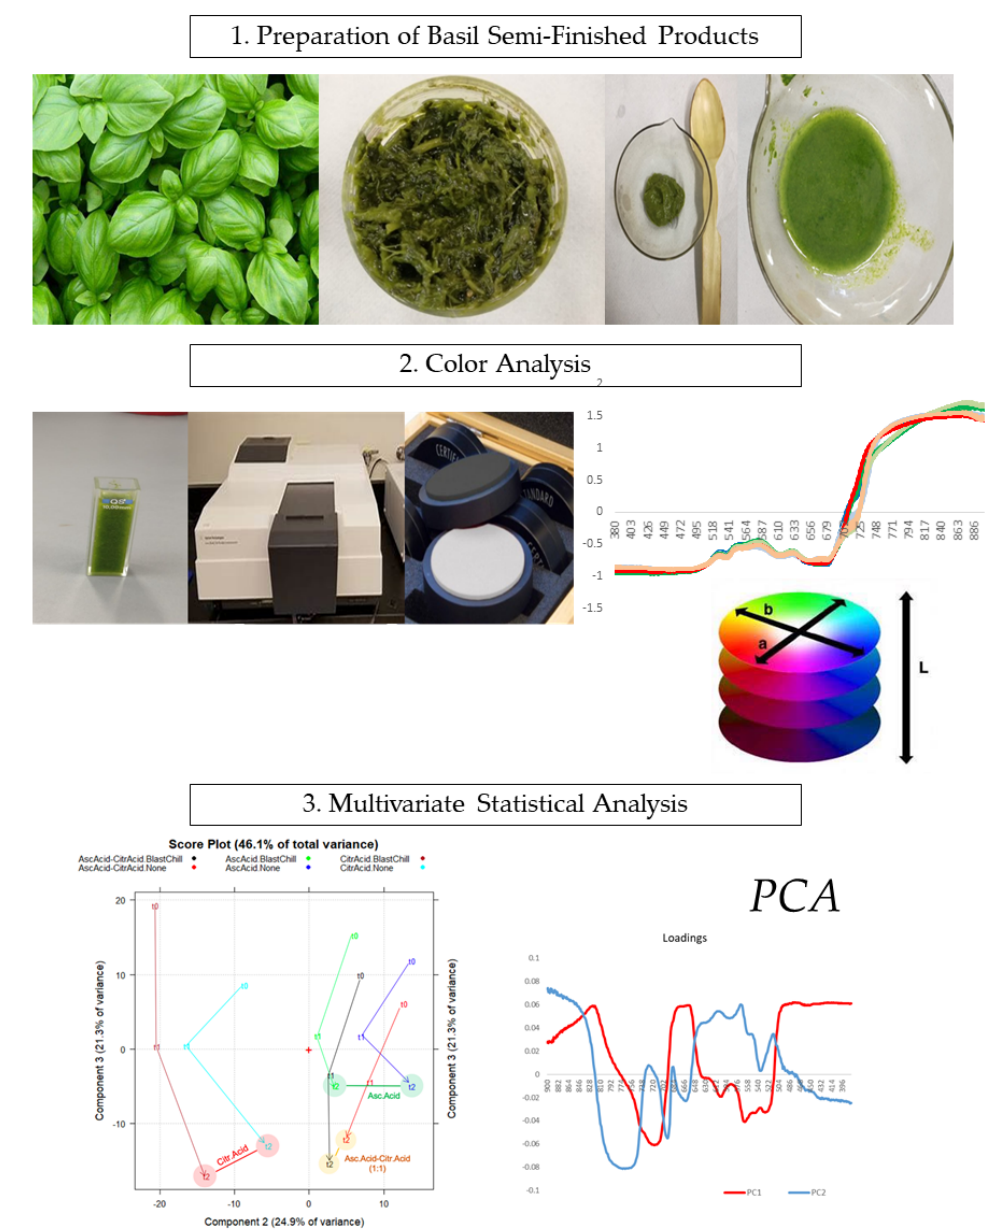
Figure 1. The color study of basil-based semi-finished products.